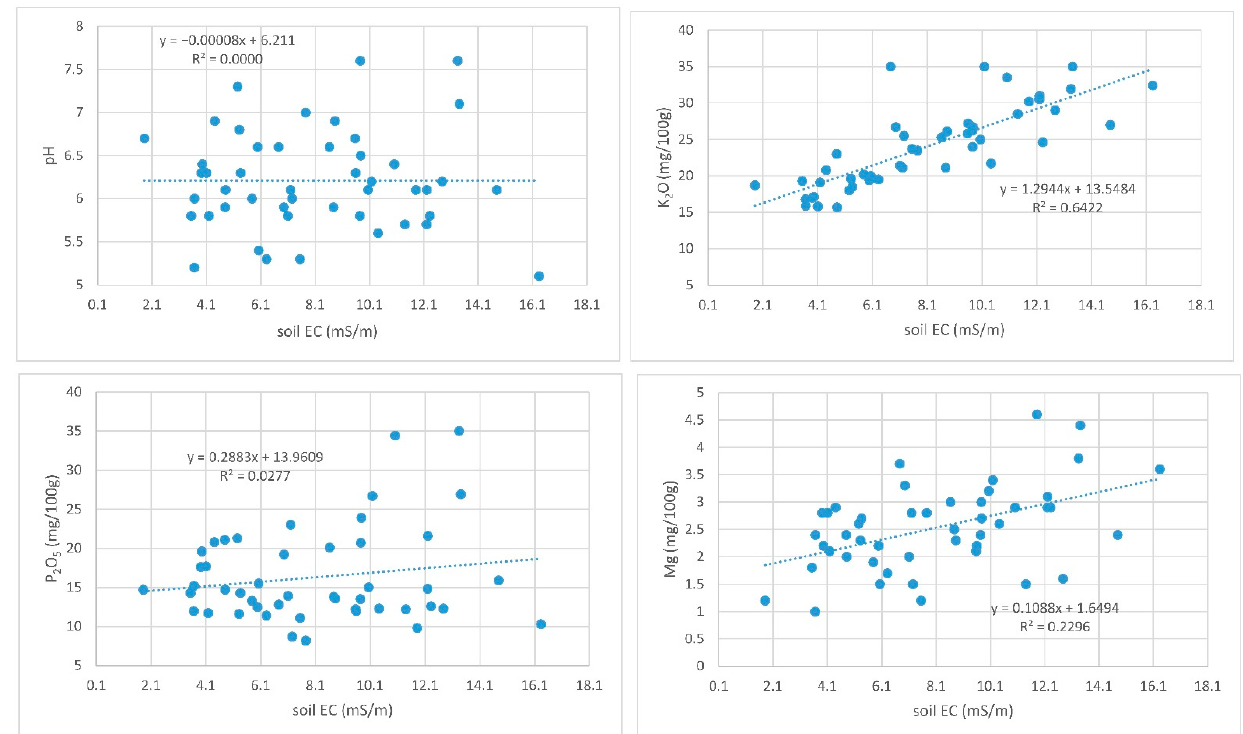
Figure 5. The relationship between soil EC and pH, as well as nutrient content, in soil evaluated using simple linear regression. using simple linear